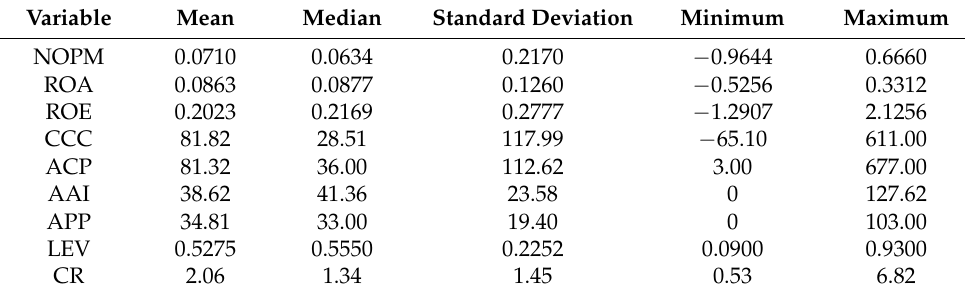
Table 2. Summary of descriptive statistics.